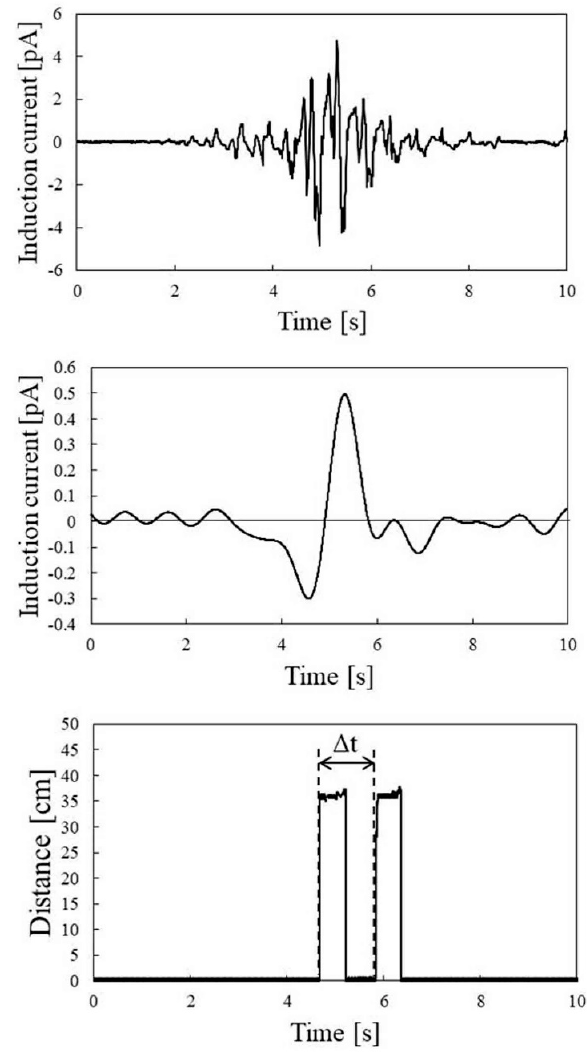
Figure 9. Electrostatic induction current trace induced by walking motion ( upper panel ), electrostatic induction current trace after passing low-pass filter ( middle panel ), and distance measurement trace obtained by distance measurement sensor module ( lower panel ).